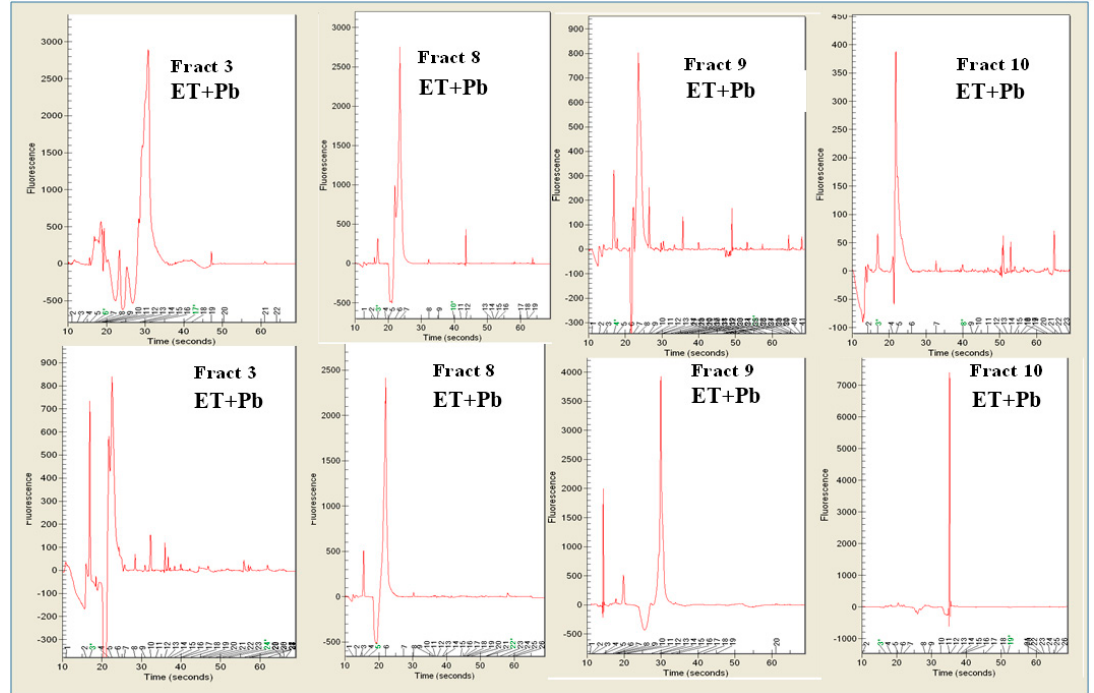
Figure 6. Electropherograms of some fractions obtained after micro 2D electrophoresis of the proteins present in Thermus thermophilus grown with (CHT + Pb 2+ ) and (CHT) without Pb 2+ and excreted by the strain grown with (ET + Pb 2+ ) and (ET) without Pb 2+ . Proteins were divided in ten fractions, following their pI.